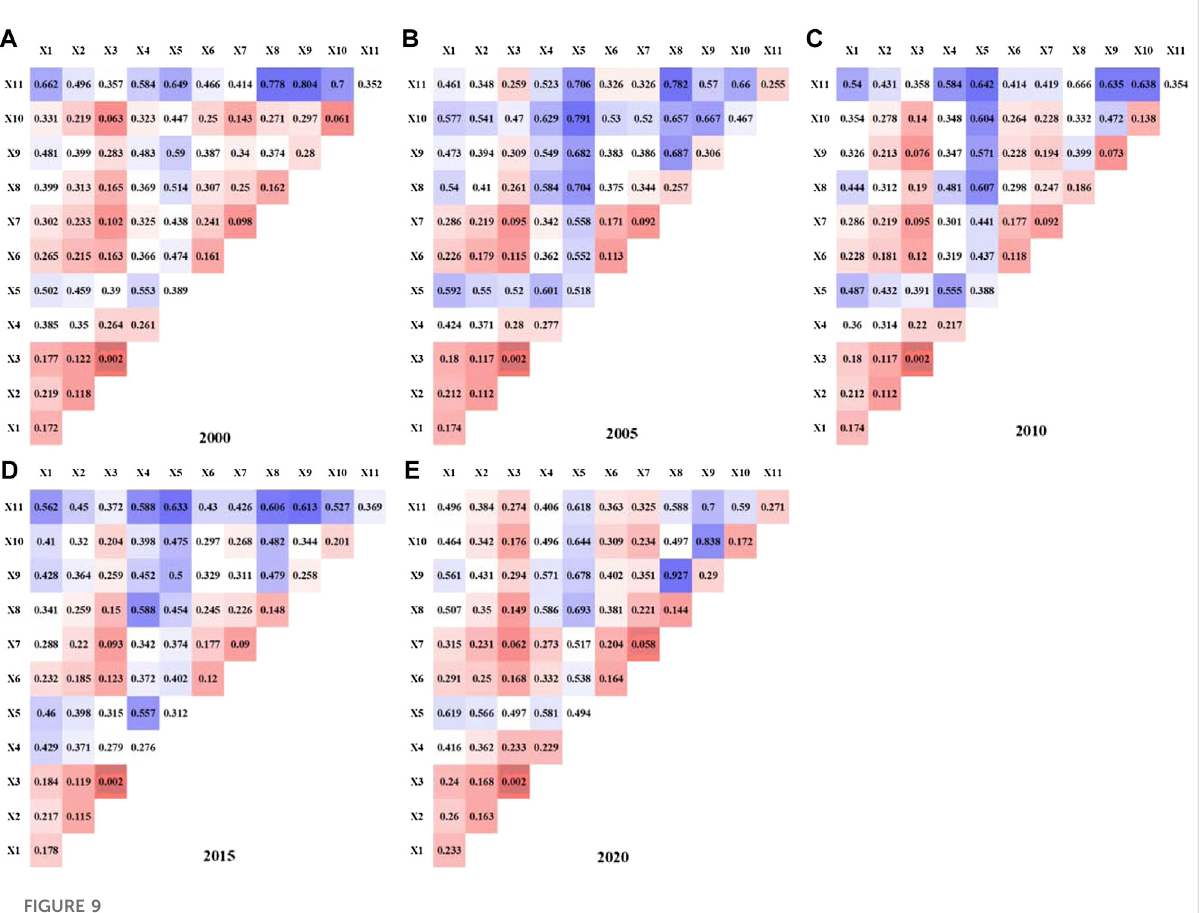
FIGURE 9 Interactive detector